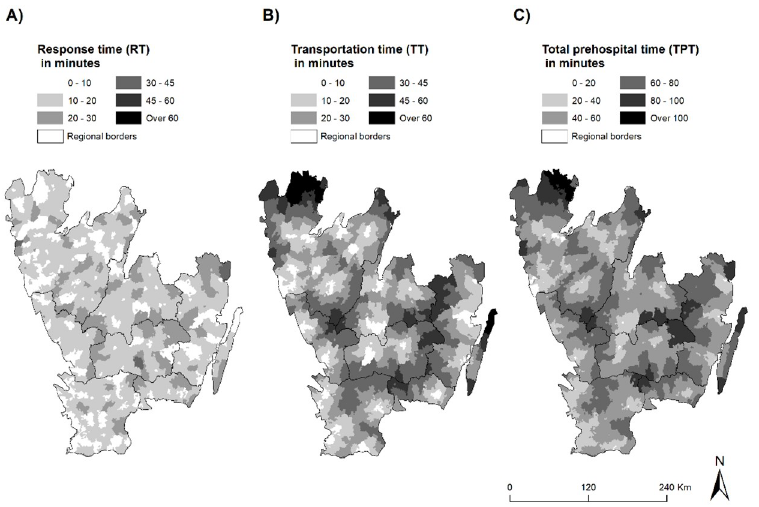
Fig 2. Visualizations of accessibility measures. Maps showing how RT, TT and TPT vary across the study area. Source: Authors.